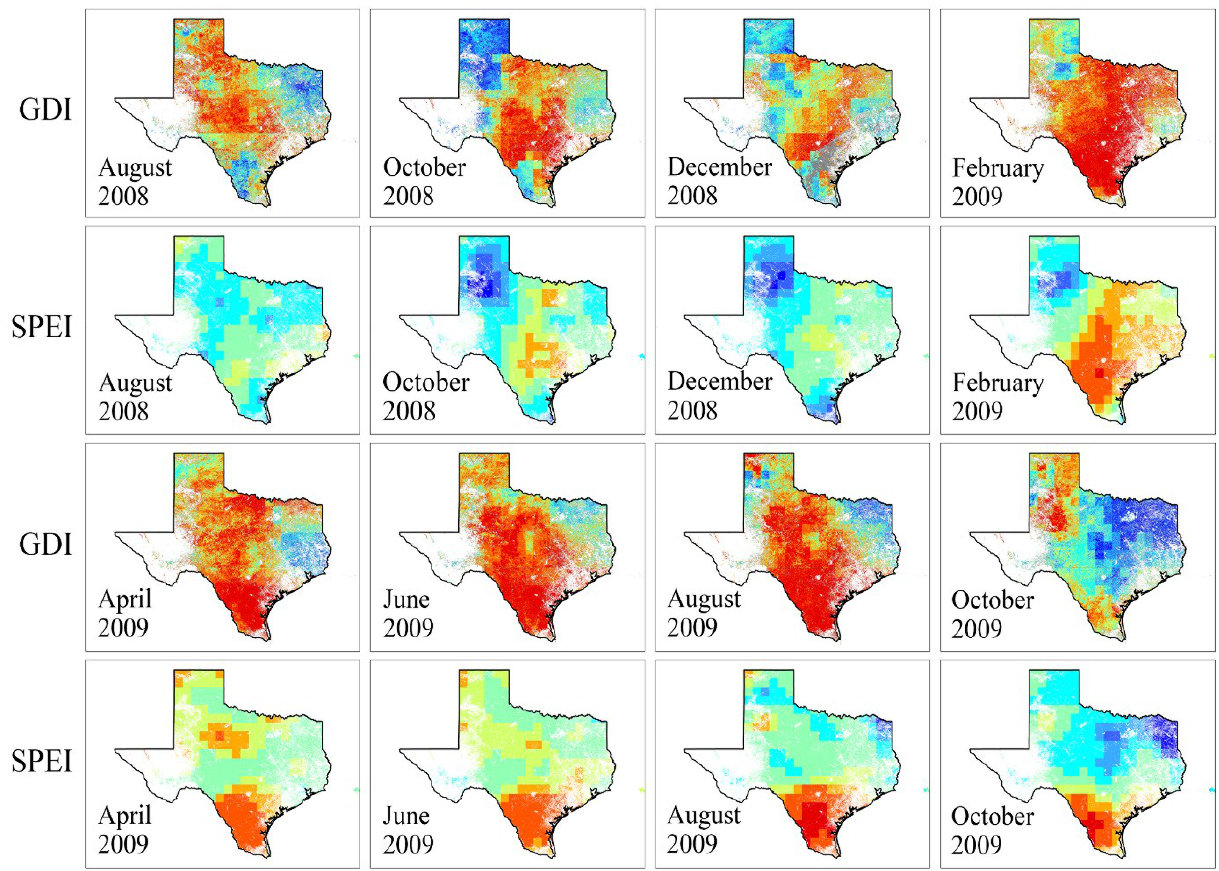
Figure 13. The performance of the global products of GDI-6CRU and SPEI-6mon in grassland regions, regarding the drought event in 2008 and 2009, Texas, US. The classification scheme of GDI-6CRU and SPEI SPEI-6mon are same with the scheme adopted in Figures 9–11.